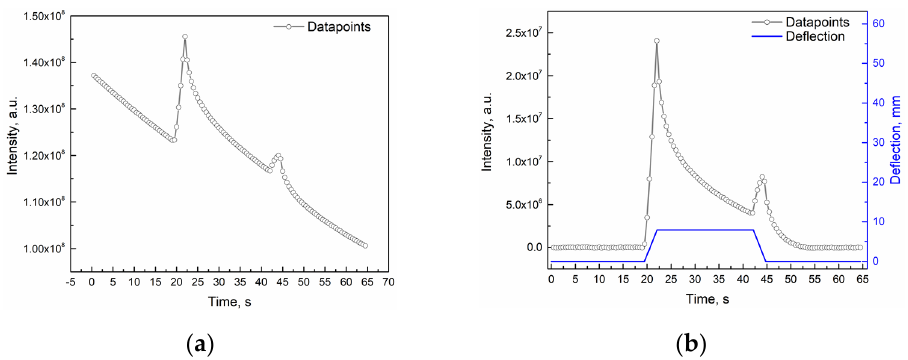
Figure 2. ( a ) Integral luminescent emission in one loading–unloading cycle of the 3D-printed sample with 10 luminescent layers; ( b ) deflection of sample and illustration of ML without background afterglow of SrAl 2 O 4 : Eu, Dy.